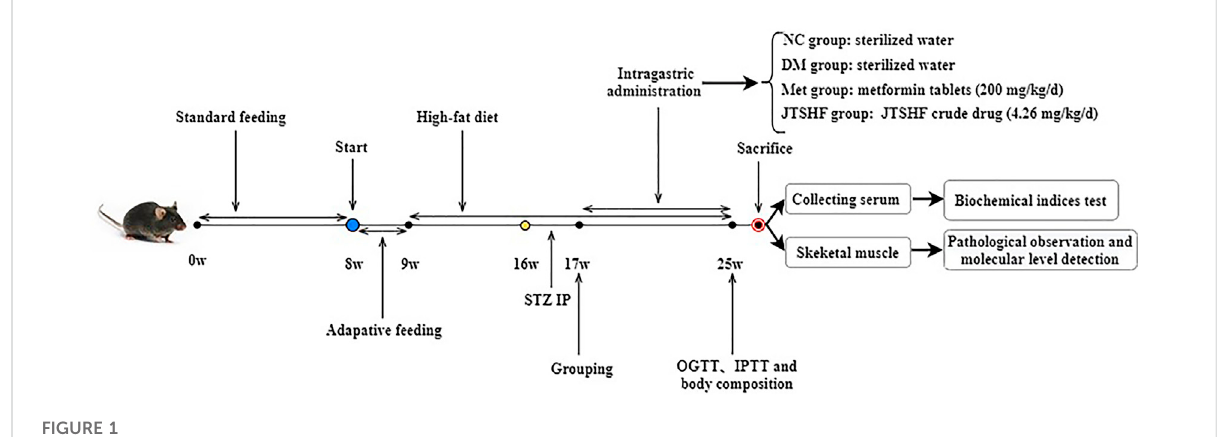
FIGURE 1 The fl ow chart of the animal